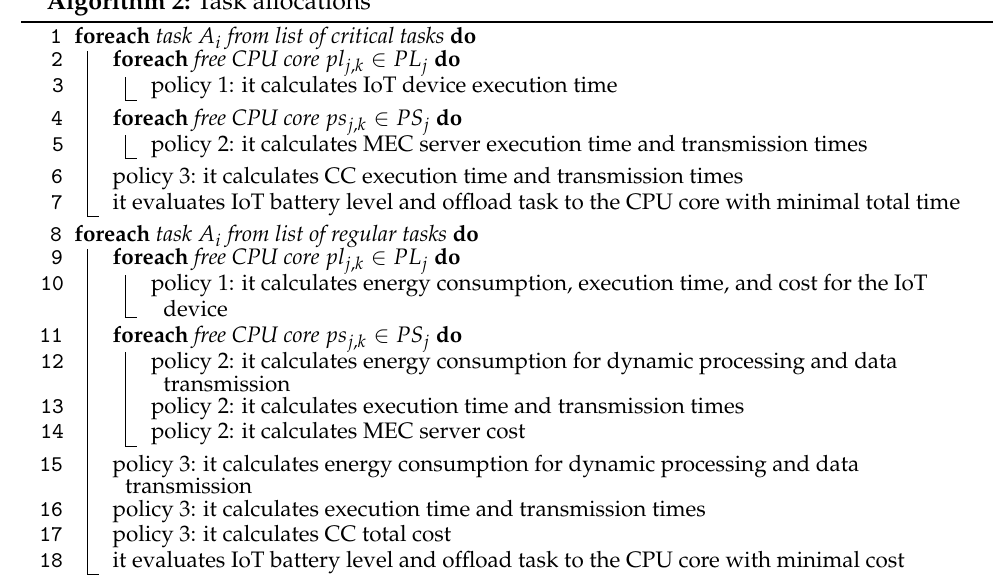
Algorithm 2: Task